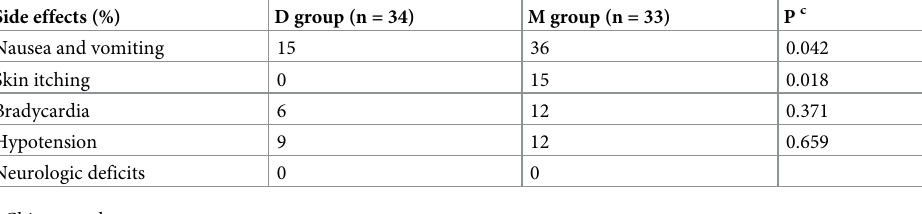
Table 3. The comparison of postoperative side effects observed in both the groups. Side effects (%) D group (n = 34) M group (n = 33) Nausea and vomiting 15 Skin itching